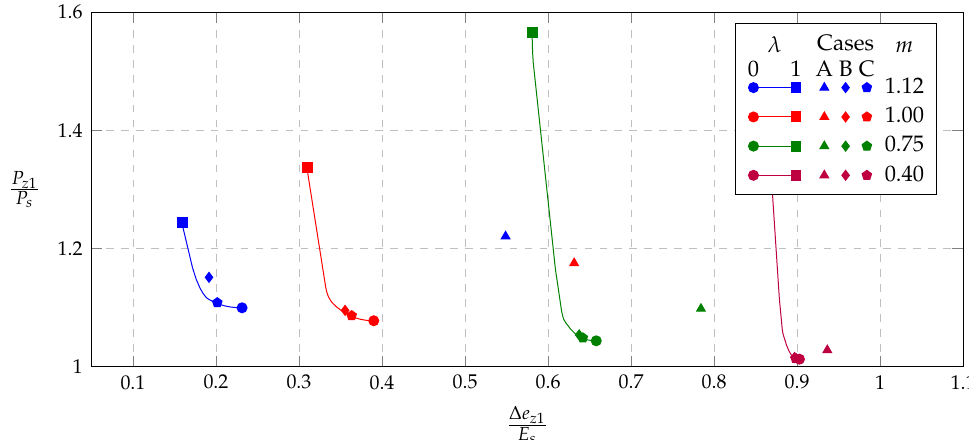
Figure 3. Pareto frontier for a low-voltage MMC with R z = 166.9m Ω , V Tz = 4.522V and ˆ I = 10A at φ = 0° and 0.4,0.75,1.00,1.12 . m ∈ { }